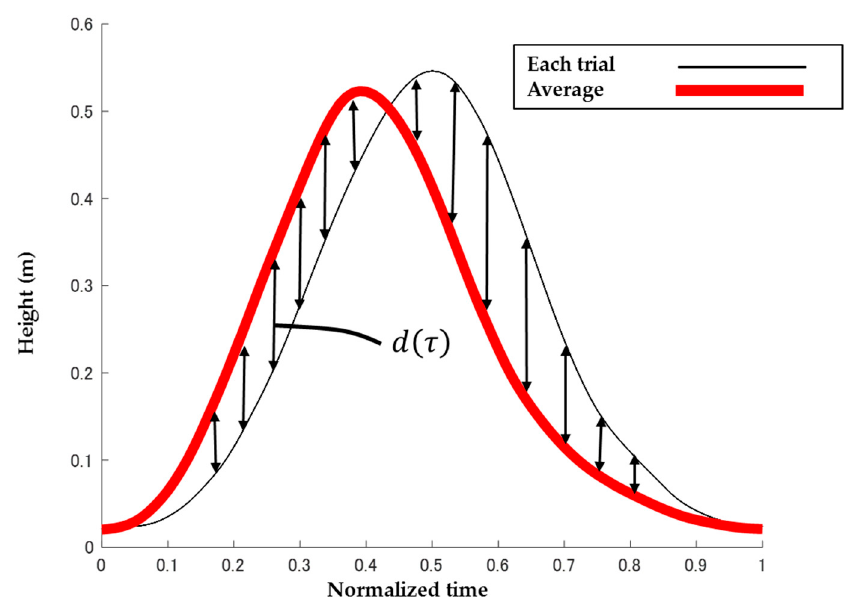
Figure 4. Example of calculation of the distance error.